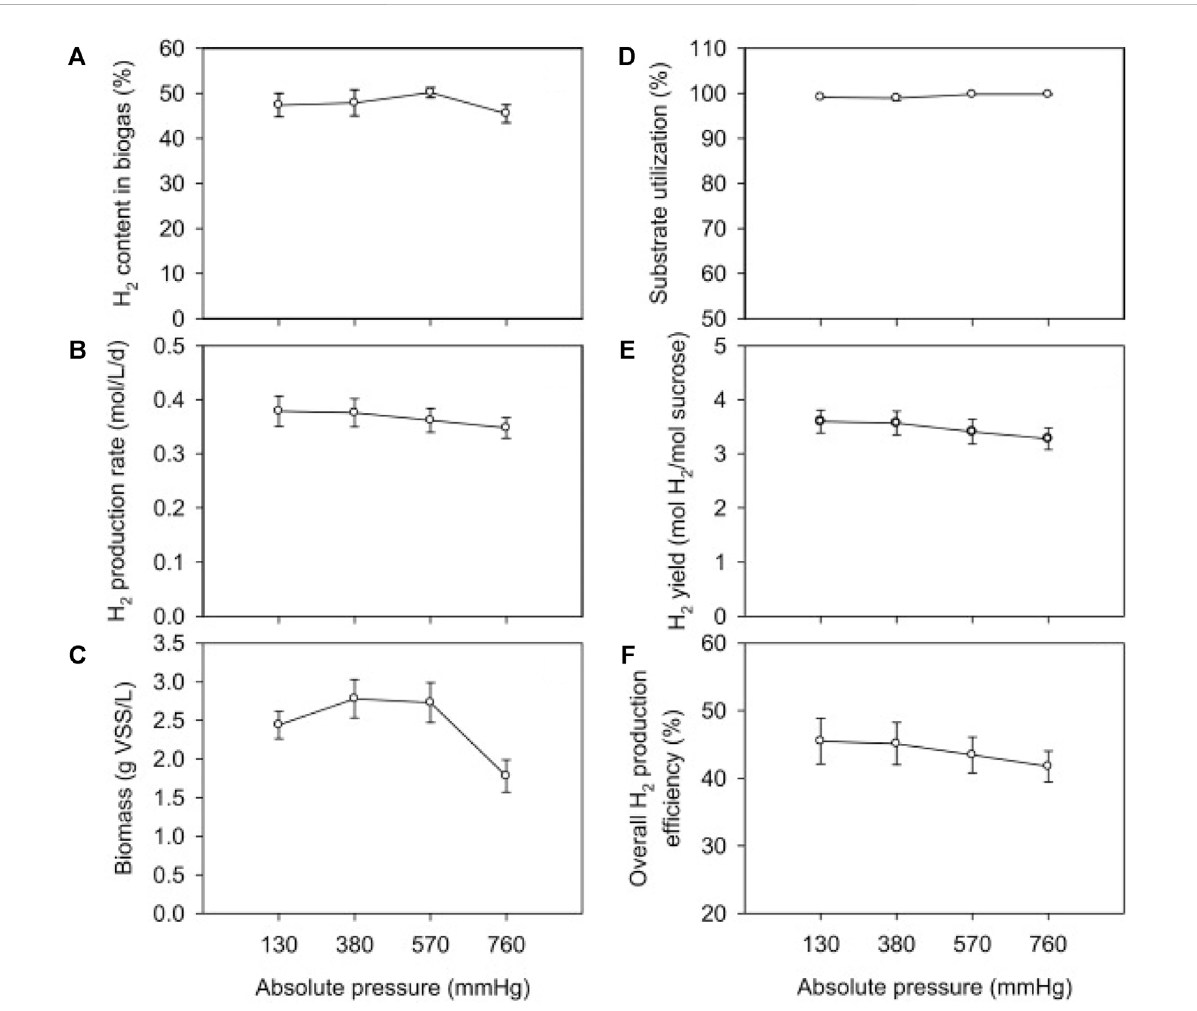
FIGURE 6 The effect of pressure on (A) H 2 contentinbiogas, (B) H 2 productionrate (HPR), (C) biomass concentration, (D) substrate utilization, (E) H 2 yield (HY), and (F) overall H 2 production ef fi ciency when dark fermentation was operated under the condition of: HRT, 12 h; temperature, 37 ° C; substrate (sucrose) concentration, 17.8 g/L (Lee et al.,